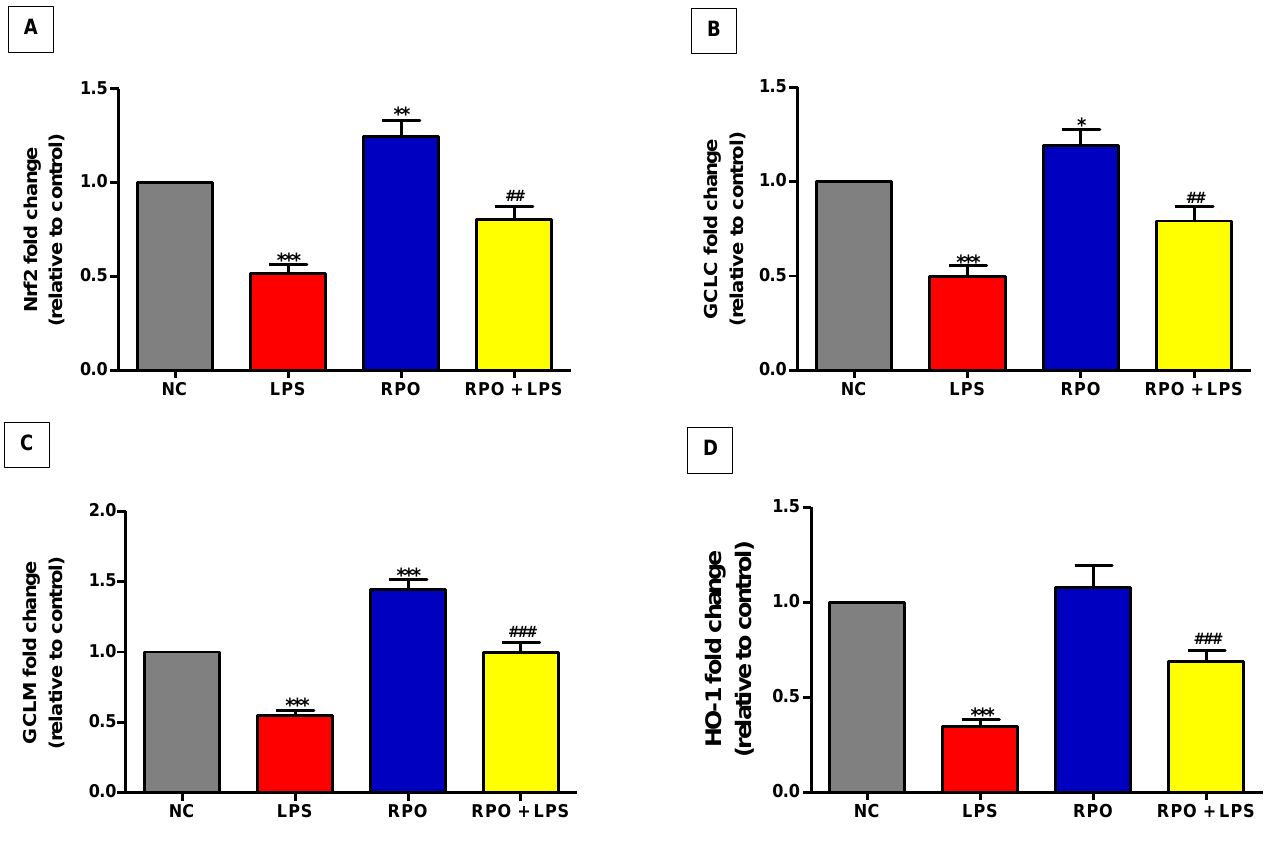
Figure 6. RPO activates Nrf2/HO-1 signaling in LPS-induced rats. RPO increased (A) Nrf2 (B) GCLC (C) GCLM and (D) HO-1 gene expression in the liver of LPS-induced rats. Data are mean ± SEM (N = 8-10). *p<0.05, **p<0.01 and ***p<0.001 as significant difference vs NC. ## p<0.01 and ### p<0.001 as significant difference vs LPS. LPS (lipopolysaccharide), NC (normal control), RPO (red palm oil).